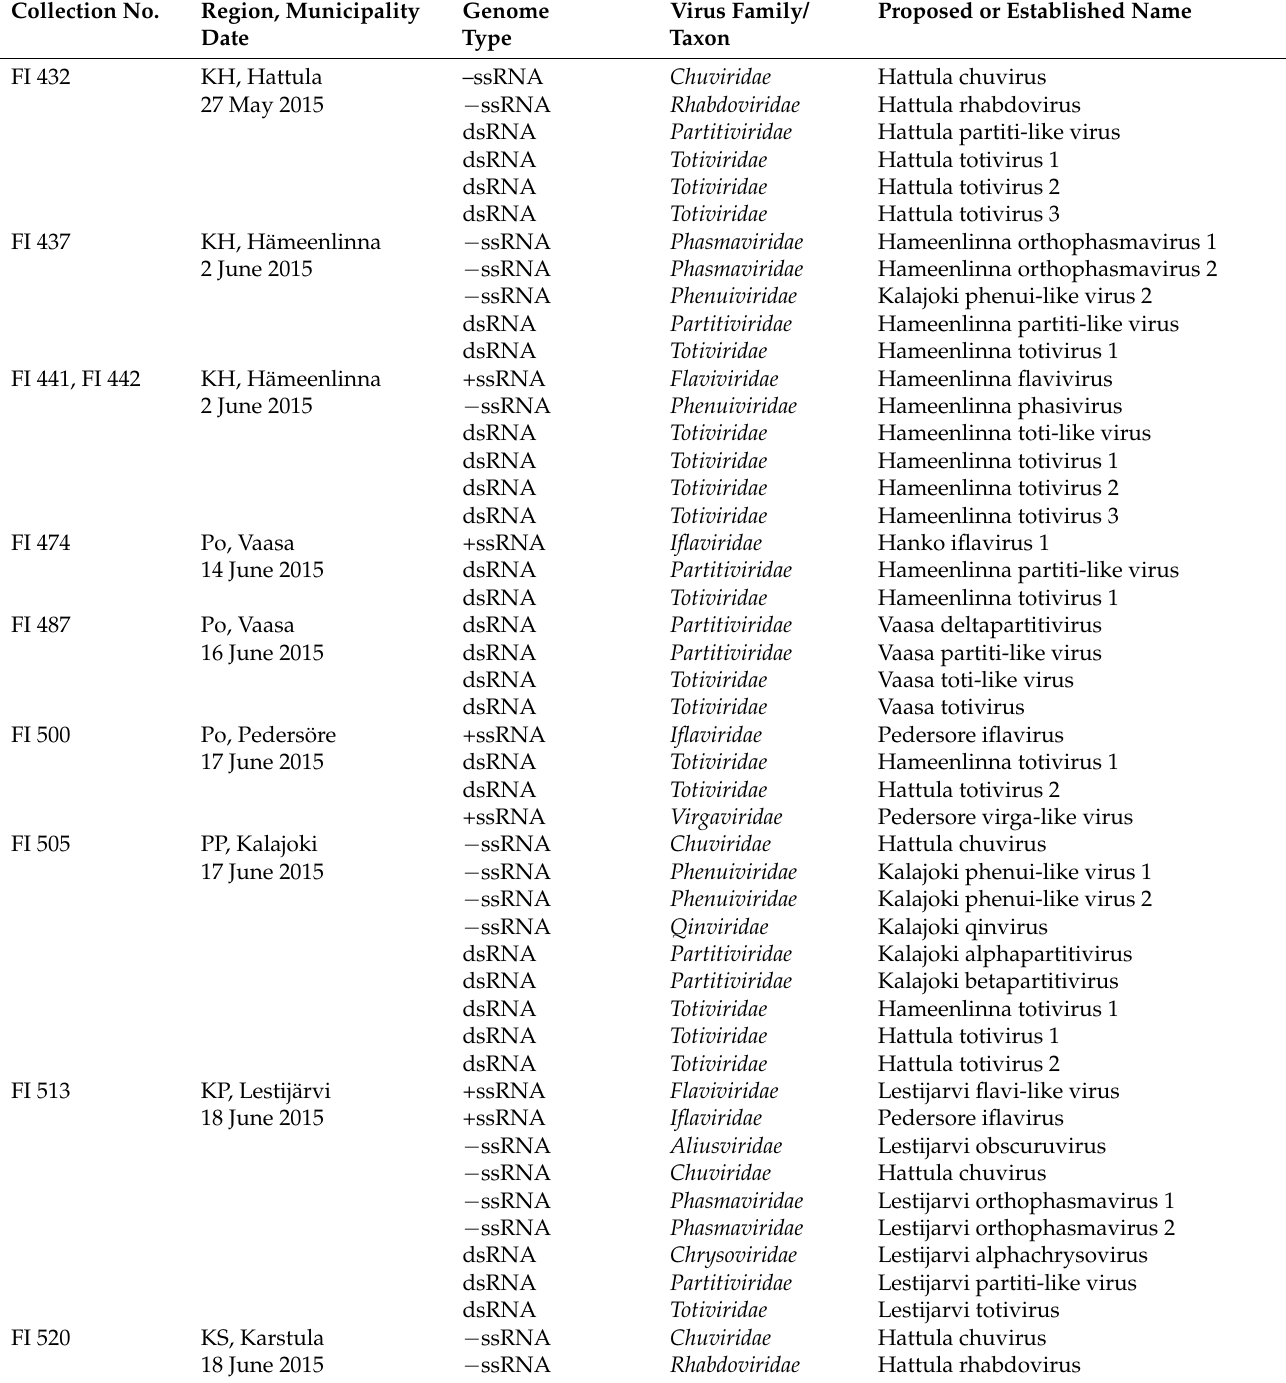
Table A1. All virus species that were sequenced in this study are displayed by the collection number from which they were obtained. Cross-reference this table with Figure 1 to visualise where each virus was present. Collections FI 1009, FI 1010 and FI 1011 were kept separate in the analyses but were made at the same location over two days and so are displayed together to avoid repetition. Region names are abbreviated, as per the codes in methods Section